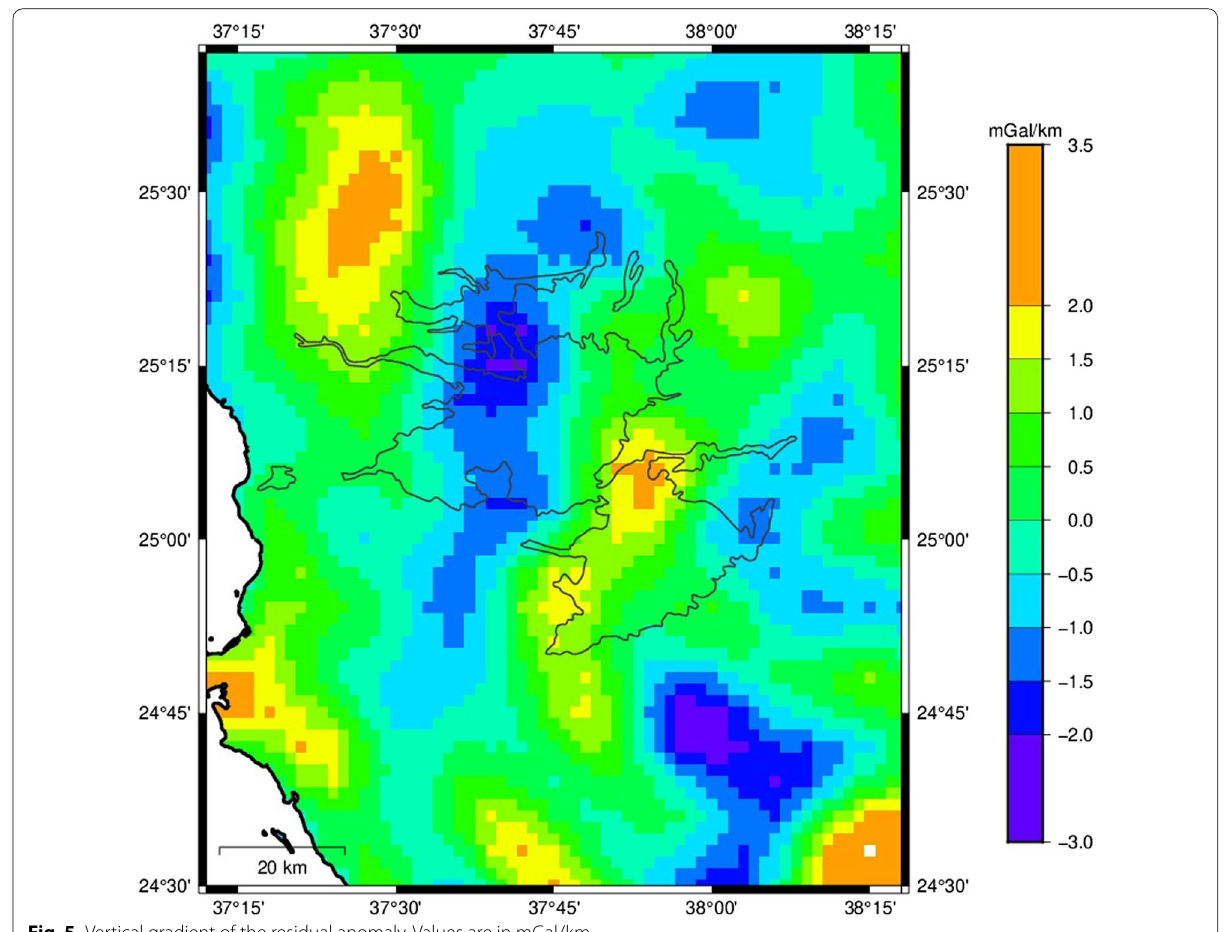
Fig. 5 Vertical gradient of the residual anomaly. Values are in